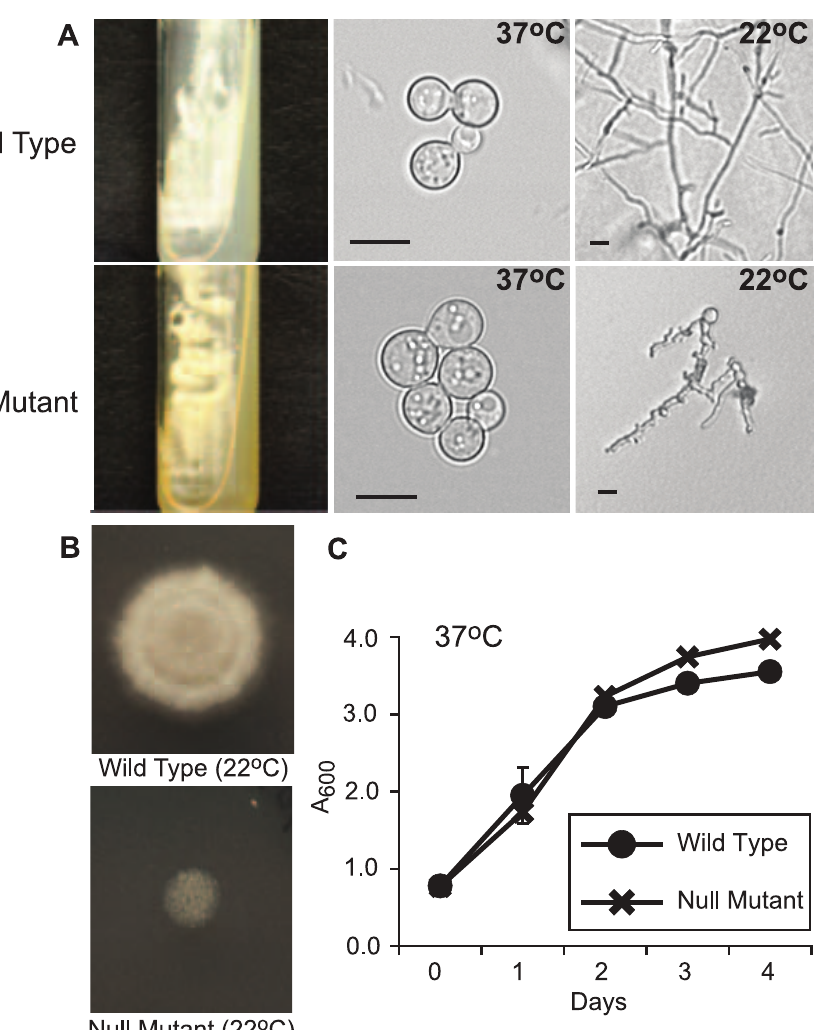
Figure 3. Phenotype of the SREB null mutant. ( A ) When grown on 7H10 medium containing 150 m M FeSO 4 , the null mutant ( SREB D ) grew as yellow-orange pigmented colonies that discolored the medium (37 u C; 15 days incubation). In contrast the wild-type strain (ATCC 26199) grew as white colored yeast and did not pigment the medium. At 37 u C, SREB D and wild-type isolates grew as budding yeast. Following a shift in temperature from 37 u C to 22 u C, SREB D failed to complete the conversion from yeast to mycelia (17 days; HMM medium). ( B ) The null mutant ( SREB D ) does not accumulate significant biomass or expand by radial growth when compared to the wild-type isolate. For each strain, 2.5 6 10 4 yeast were spotted on HMM medium and incubated at 22 u C for 14 days. ( C ) The null mutant ( SREB D ) and wild-type isolates have a similar growth rate when they are cultured as yeast at 37 u C incubation. Culture density was measured in triplicate at A 600 . Cultures were grown in liquid HMM supplemented with 10 uM FeSO 4 . The data were from two independent experiments.